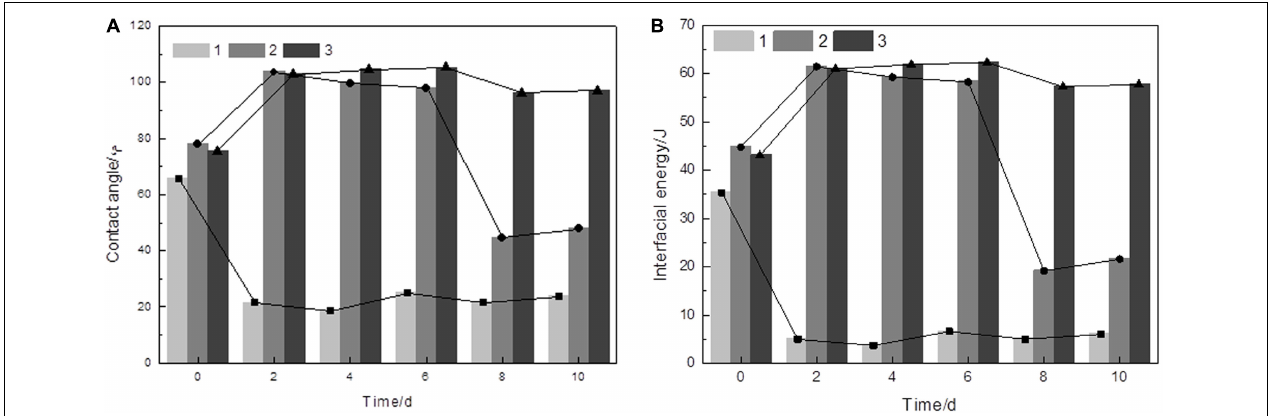
FIGURE 1 | Variation of the contact angle (A) and interfacial energy values (B) of the initial arsenopyrite samples (0 day) and the arsenopyrite samples bioleached for 2, 6, 8, and 10 days. 1, arsenopyrite covered by biofilms, 2, arsenopyrite treated by ultrasonication for 30 min, 3, arsenopyrite washed with 1 M HCl. Bioleaching assays were done at an initial pH of 1.5 and with a cell density of 1.8 × 10 8 cells/mL at 45 ◦